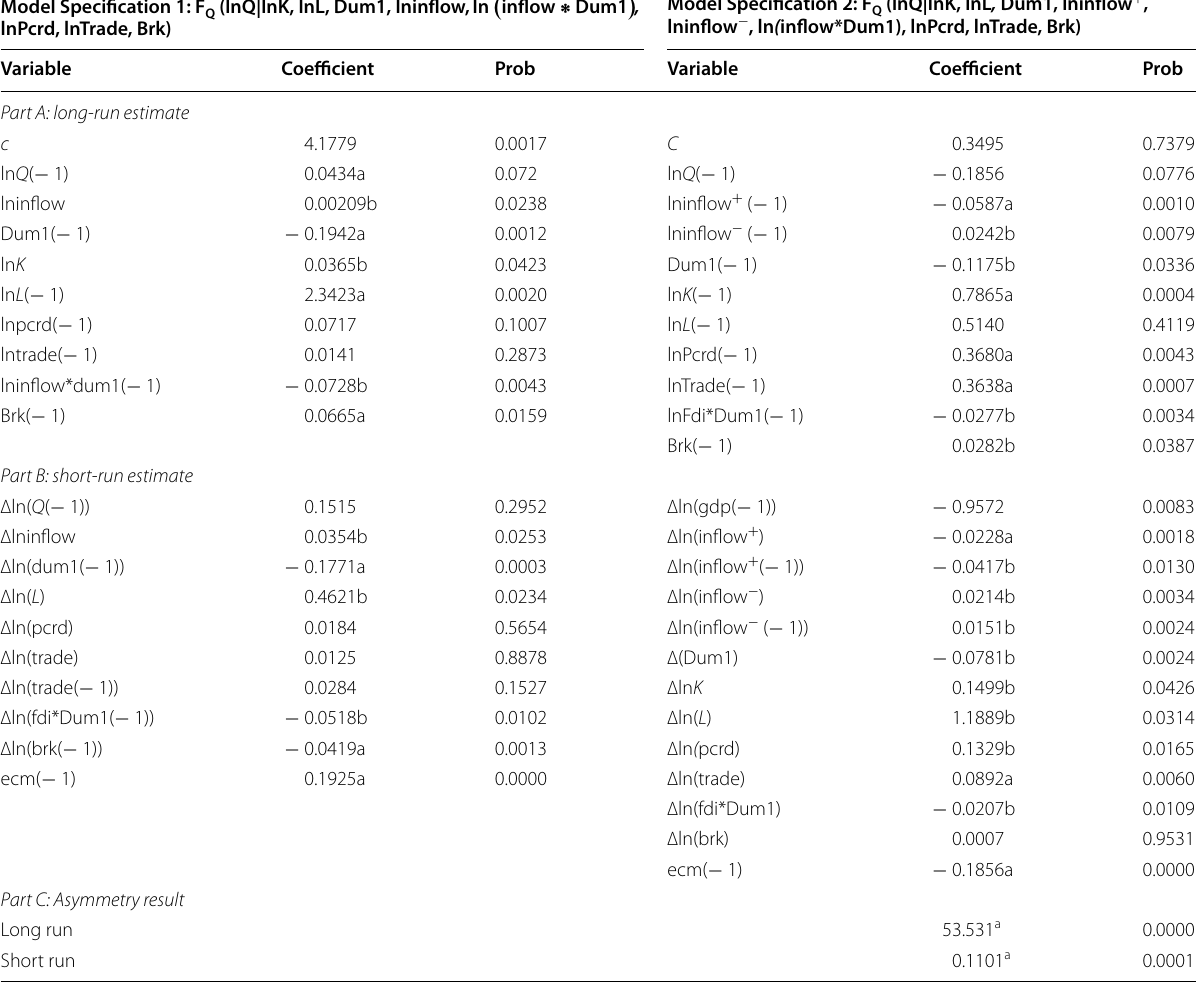
a and b Indicate 1% and 5% level of